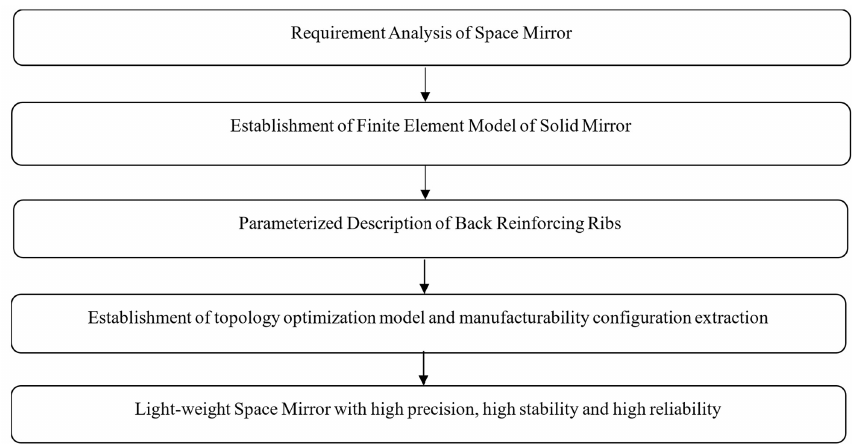
Figure 2. Optimizing design process of light-weight space mirror.